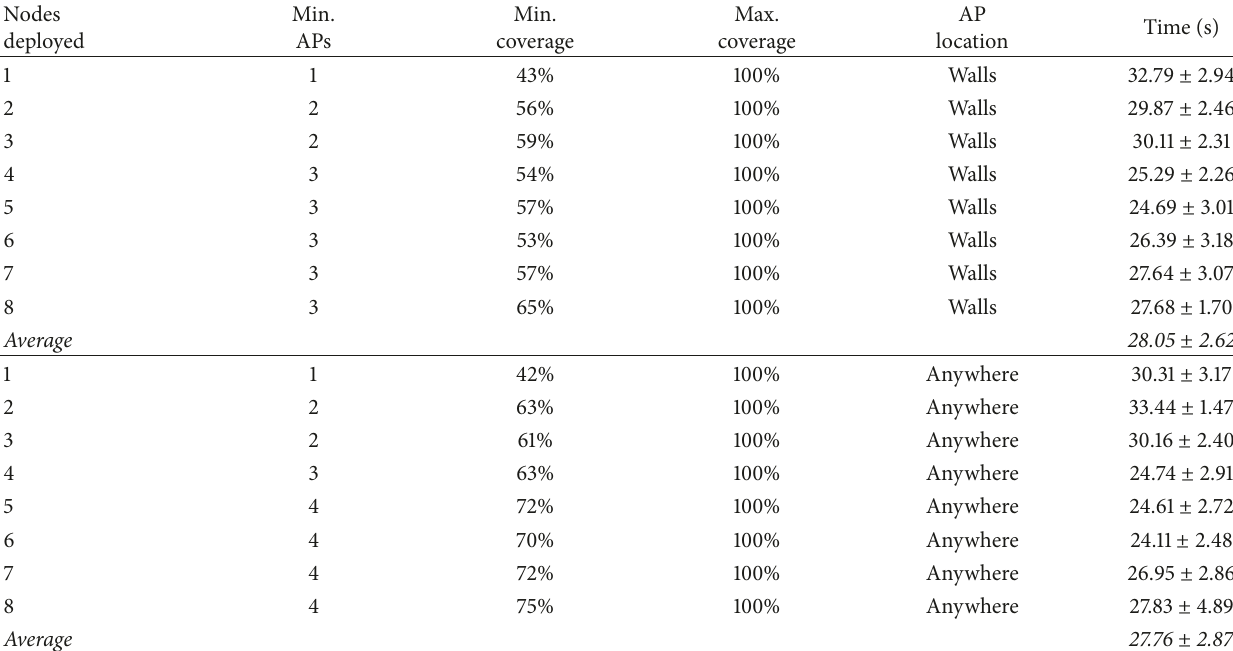
Table 7: Performance of NSGA-II in a medium scenario.